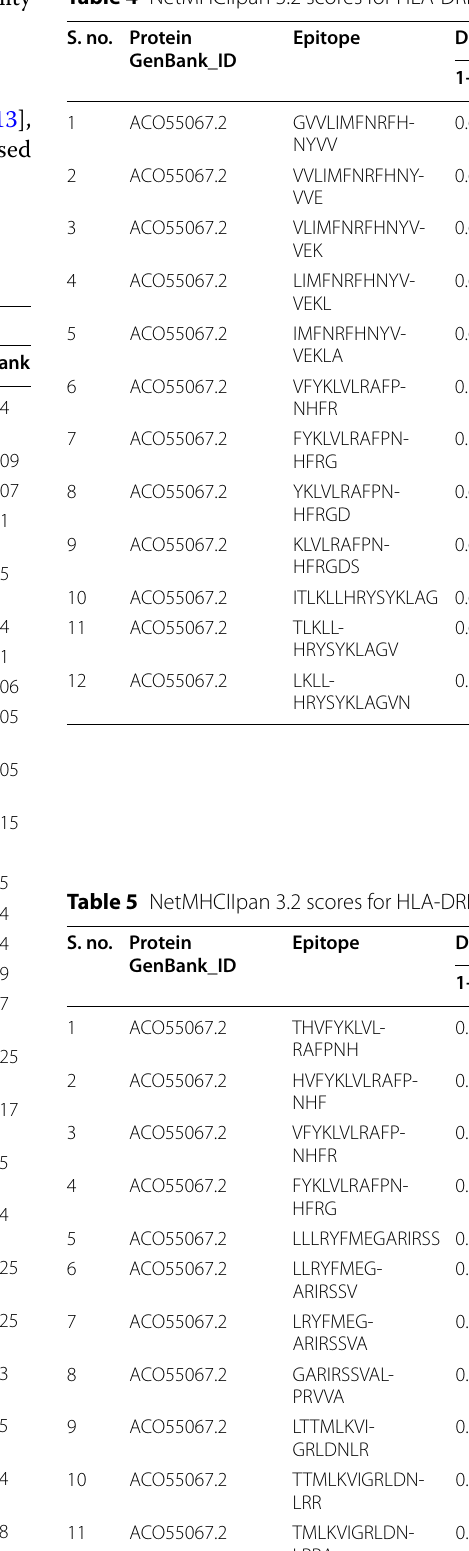
Table 4 NetMHCIIpan 3.2 scores for